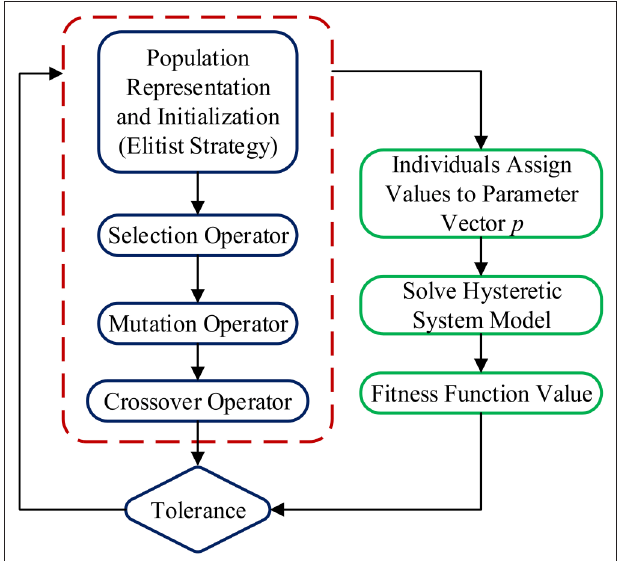
FIGURE 5 | A flow chart of system identification using GA.